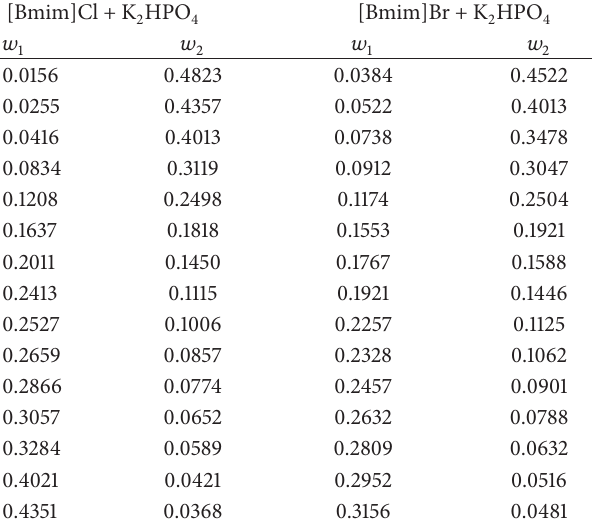
Table 1: The phase compositions of ILs (1) + K at 𝑇 = 298.15 K.